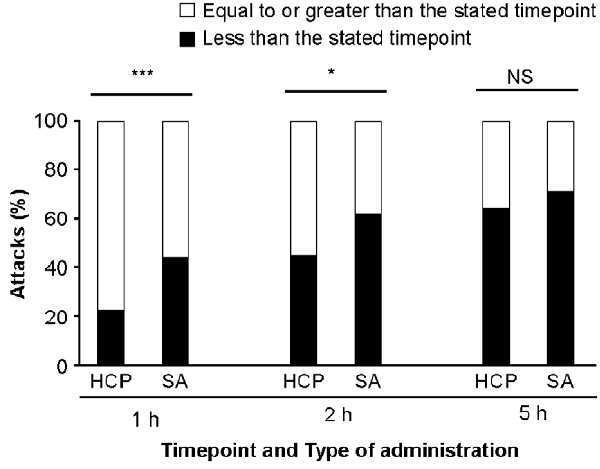
Time from attack onset to treatment Number of attacks Mild-to-moderate